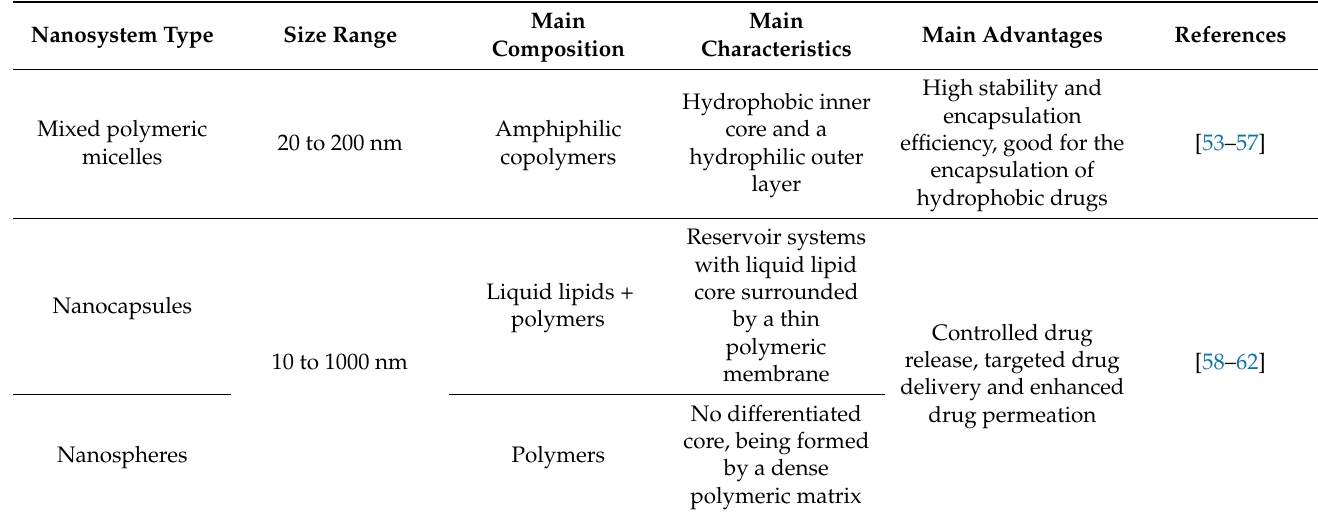
Table 1. Main types of nanosystems and respective size range and main compositions, characteristics and